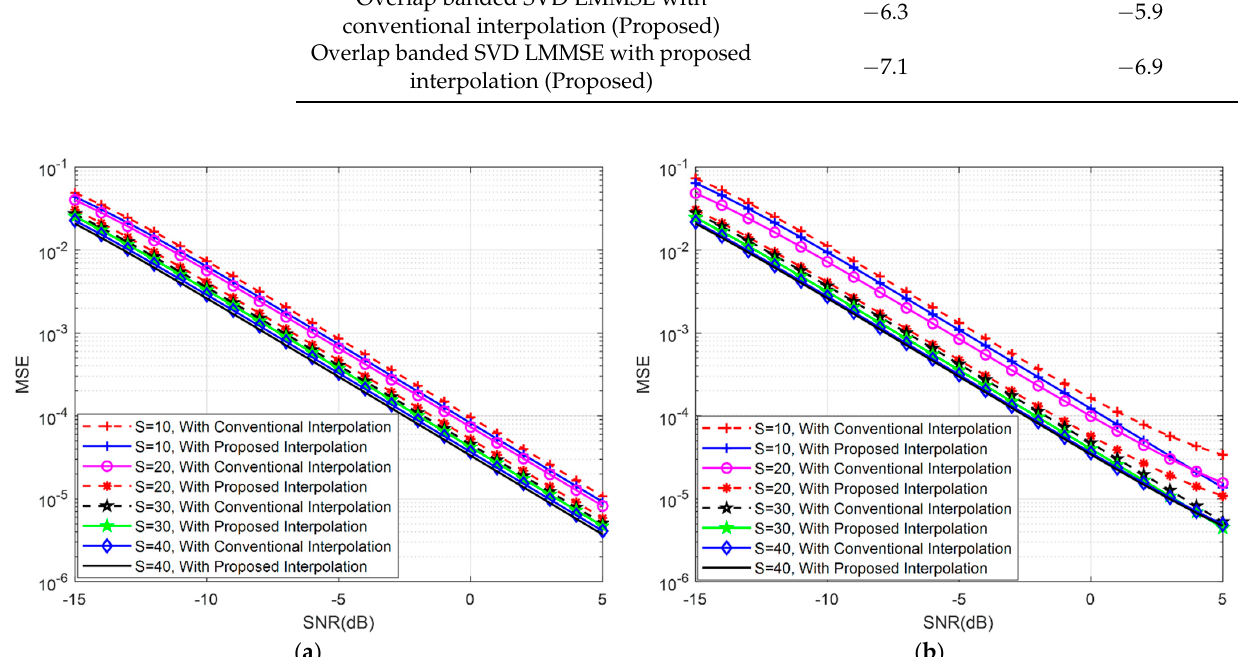
Figure 10. Mean square error (MSE) comparison of the proposed technique with conventional and proposed interpolation methods for different subvector values: ( a ) TU 1 Hz; ( b ) EPA 1 Hz.